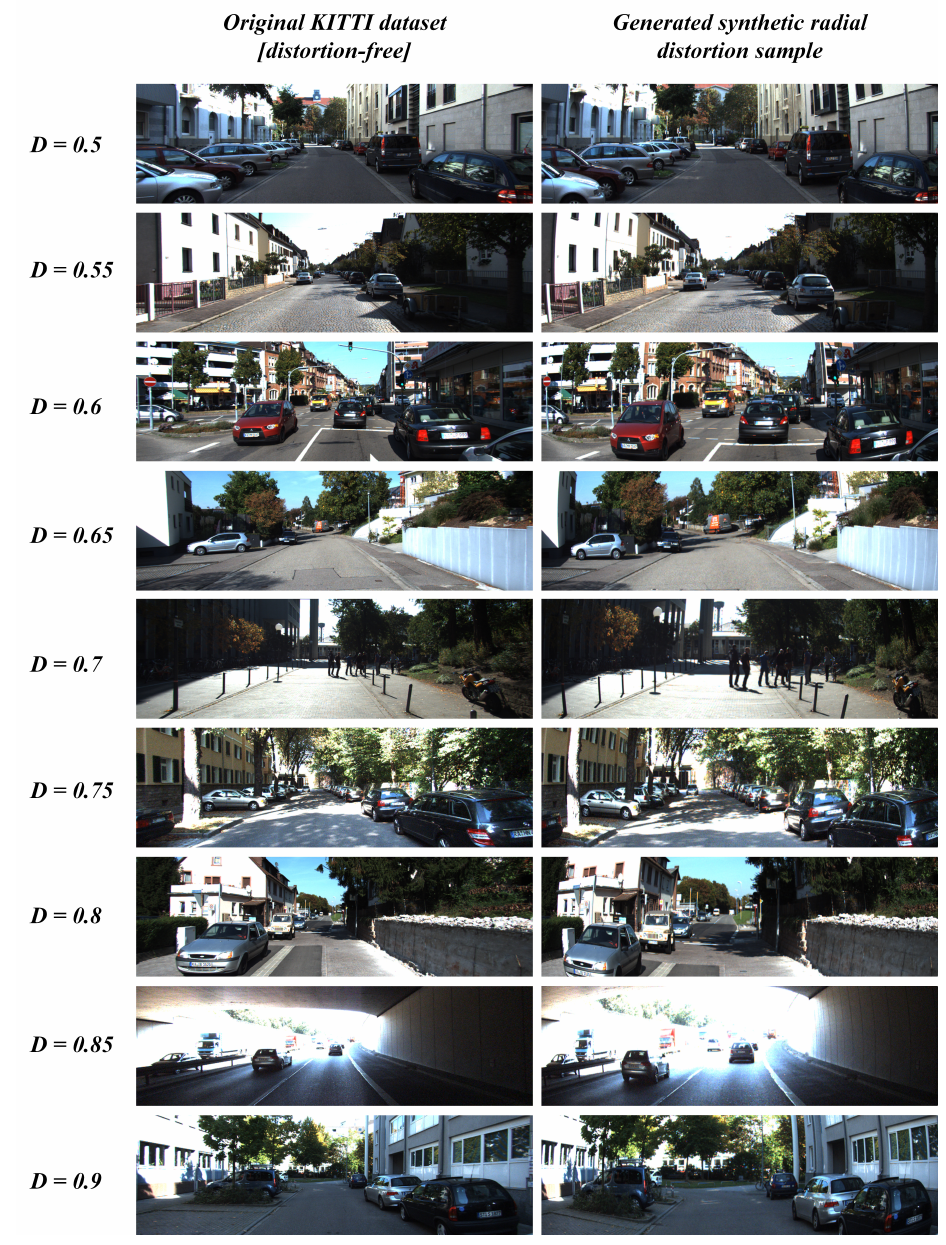
Figure 13. Synthetic distortion data generation using KITTI